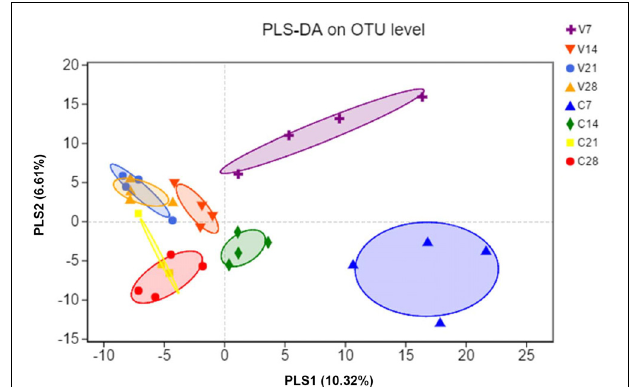
FIGURE 3 | Partial least squares discriminant analysis (PLS-DA) was performed by analyzing the operational taxonomic unit (OTU) level of all samples. Color and shape represent the different groups. PLS-DA scatterplot shows obvious separation ( P < 0.05, ANOSIM) and compositional differences in gut microbiota between PCV3- (V) and sham-inoculated (C) piglets at four time points (7, 14, 21, and 28 dpi); PLS1 and PLS2 represent 10.32 and 6.61% of variance, respectively ( X and Y